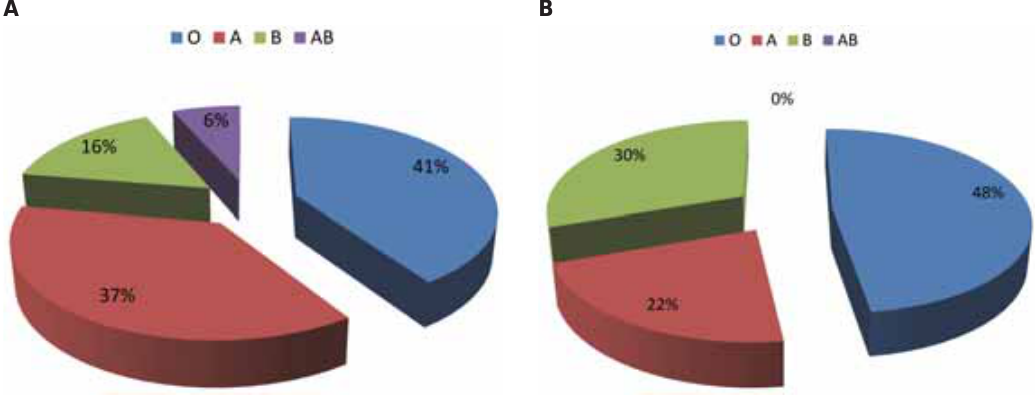
FIGURE 1. Gender distribution of ALL (A) and AML (B) in children in